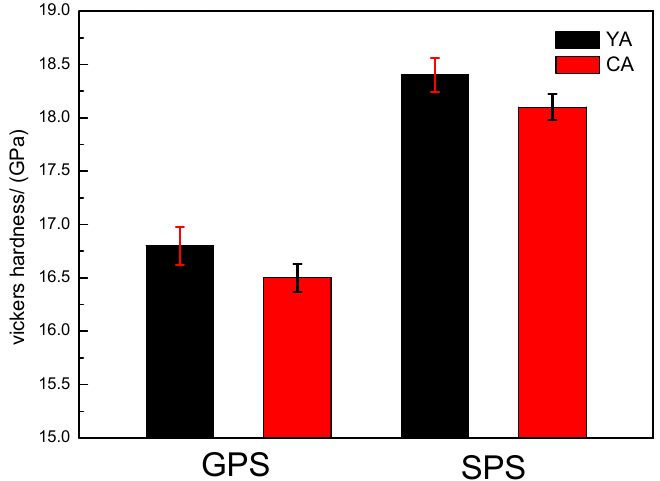
Figure 5. Micro Vickers hardness (GPa) of GPS and SPS sintered silicon nitride samples.